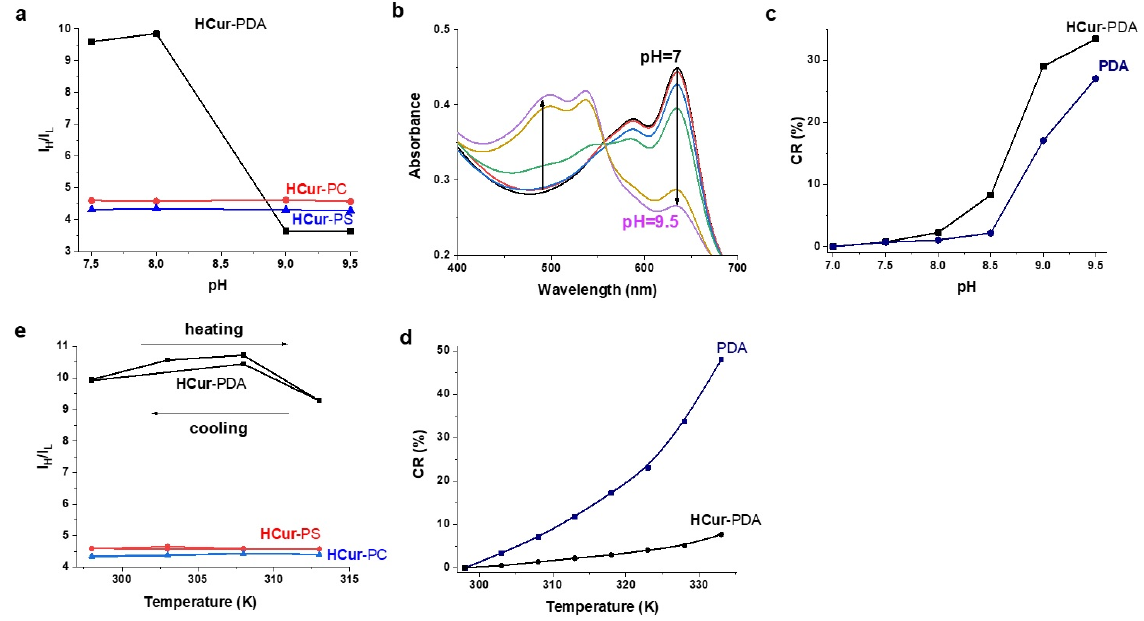
Figure 4. ( a ) I H /I L of HCur -PC, HCur -PS and HCur -PDA at different pH values; ( b ) UV-vis spectra of HCur -PDA at different pH; ( c ) colorimetric response of HCur -PDA and PDA at different pH; ( d ) colorimetric response of HCur -PDA and PDA at different temperature (T, K); ( e ) I H /I L of HCur -PC, HCur -PS and HCur -PDA at different T.